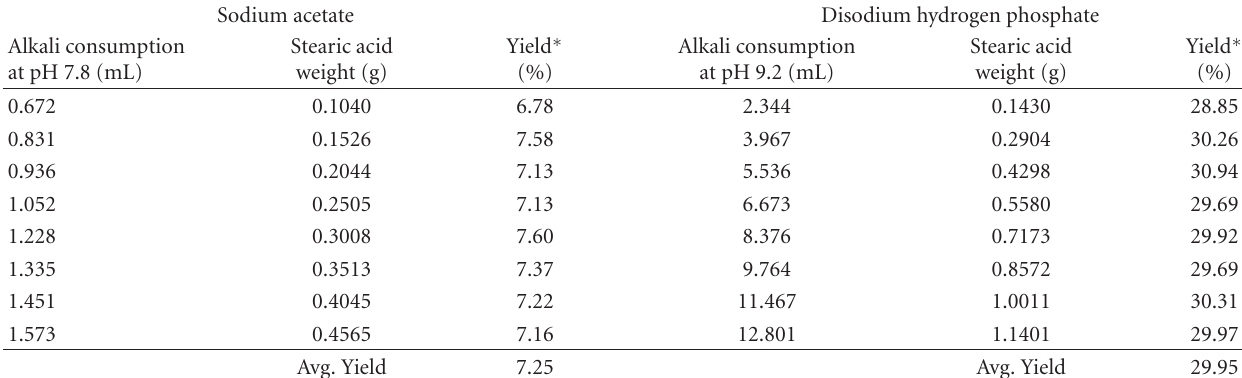
Table 2: Determination of stearic acid dissociated in CH 3 COONa and Na 2 HPO 4 solution.